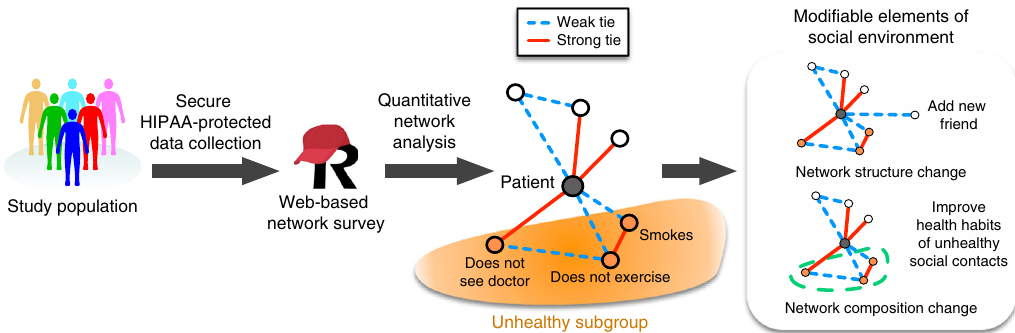
Fig. 1 Overview of data collection, analysis, and interventions. This fl owchart shows the social network data acquisition, identi fi cation of modi fi able elements in the social environment, and potential intervention strategies